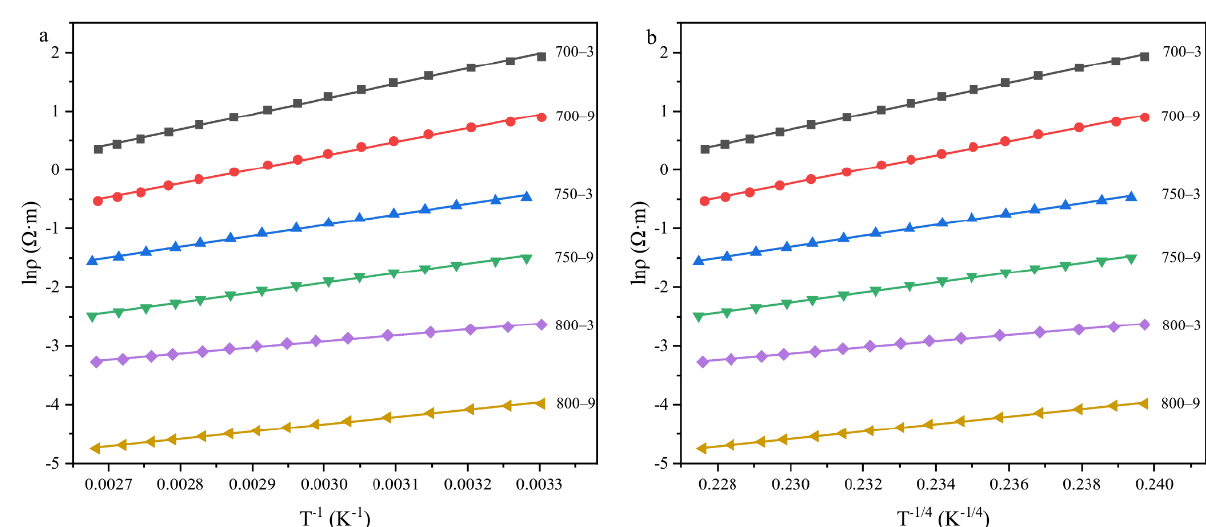
Figure 11. Temperature dependence of electrical resistivity: ( a ) fixed-range hopping used to linear fit; ( b ) variable-range hopping used to linear fit.